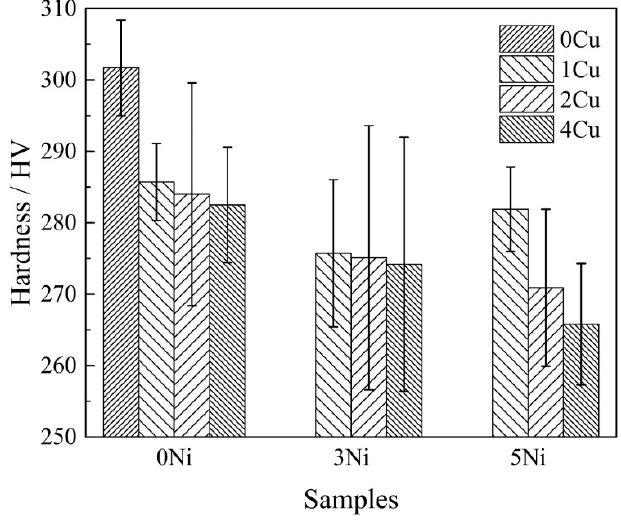
Figure 7. Microhardness of the as-cast CoCrW-xNi-yCu